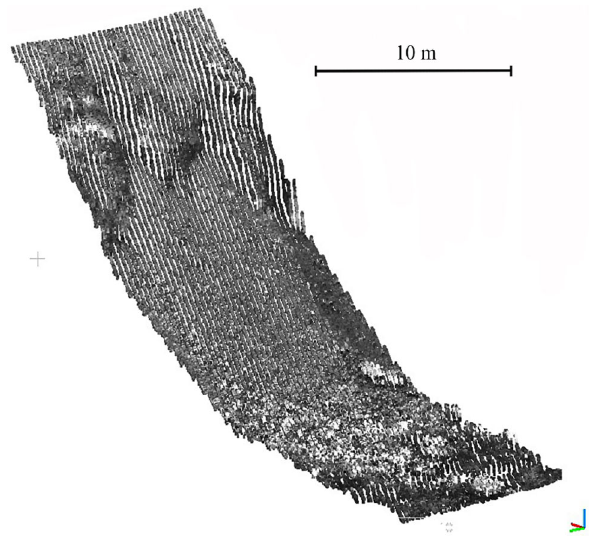
Fig. 3 The point cloud of the chosen highwall from Coc Sau open-pit